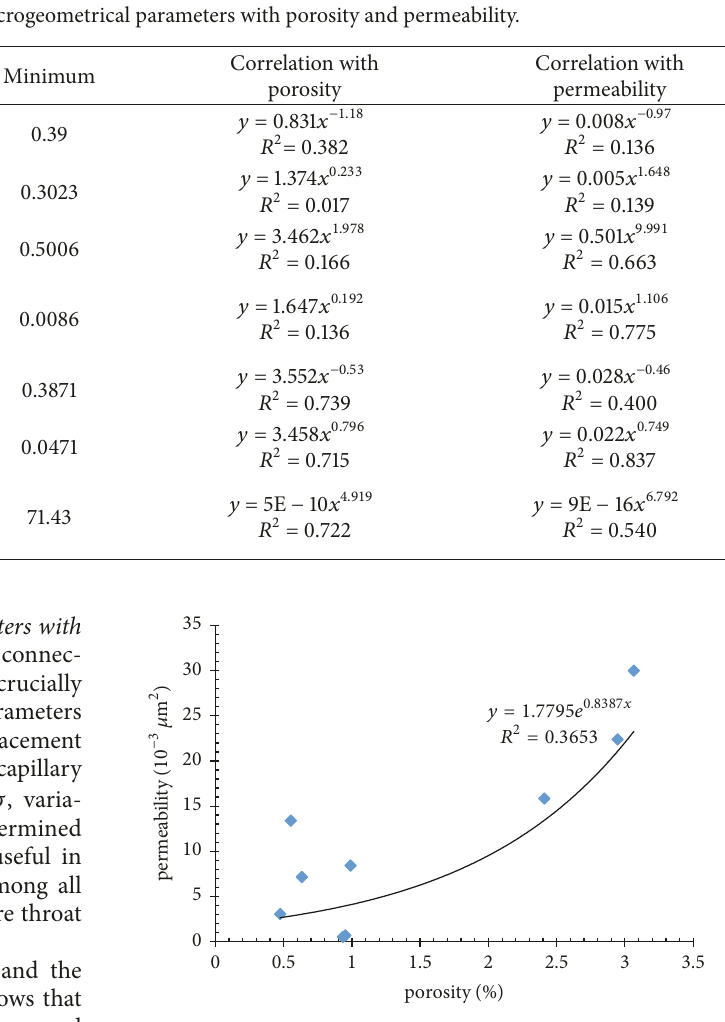
Figure 5: Relationship between porosity and permeability of rock